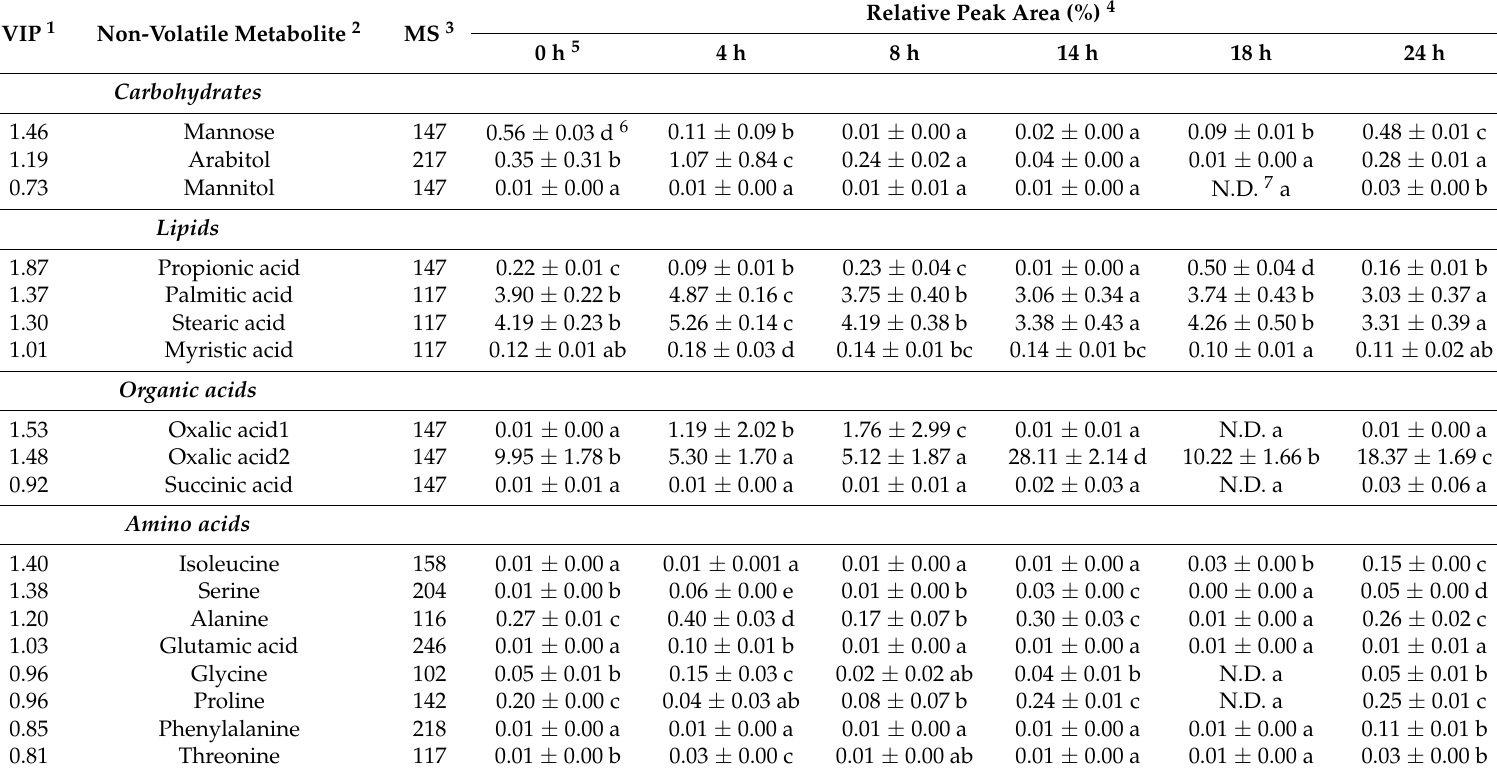
Table 3. Nonvolatile metabolites identified in S. fibuligera KJJ81 according to cultivation